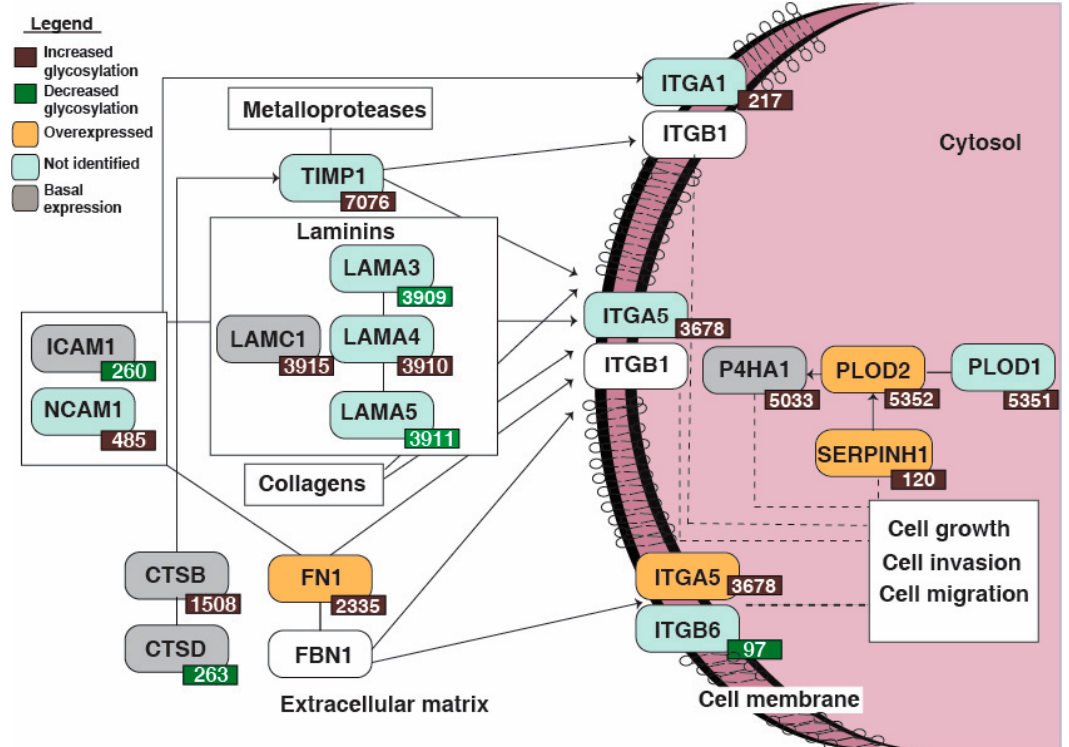
Figure 4. Schematic diagram of enriched extracellular matrix organization pathway in non-type subtype of bladder carcinoma cell lines. Reactome pathway analysis lead to the identification of extracellular matrix organization signaling to be enriched in the aggressive molecular subtype. The dysregulated glycoproteins and corresponding identified global protein expressions are highlighted in the pathway.